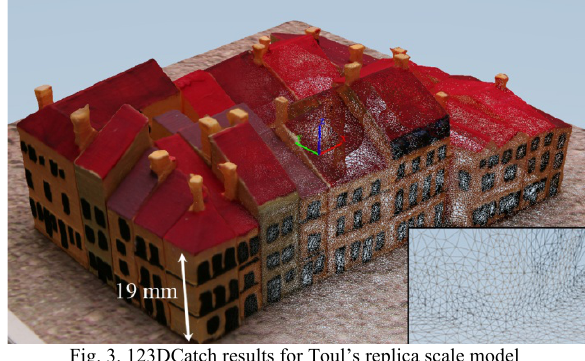
Fig. 3. 123DCatch results for Toul’s replica scale model